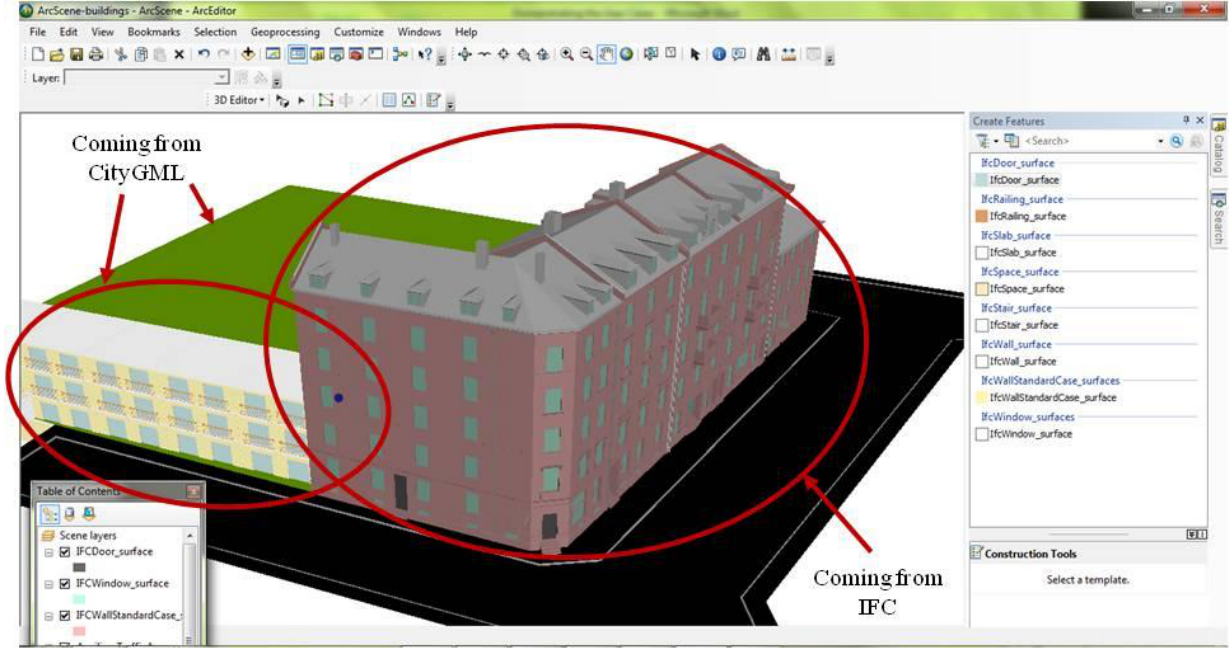
Figure 11. UBM representation of IFC and CityGML data.